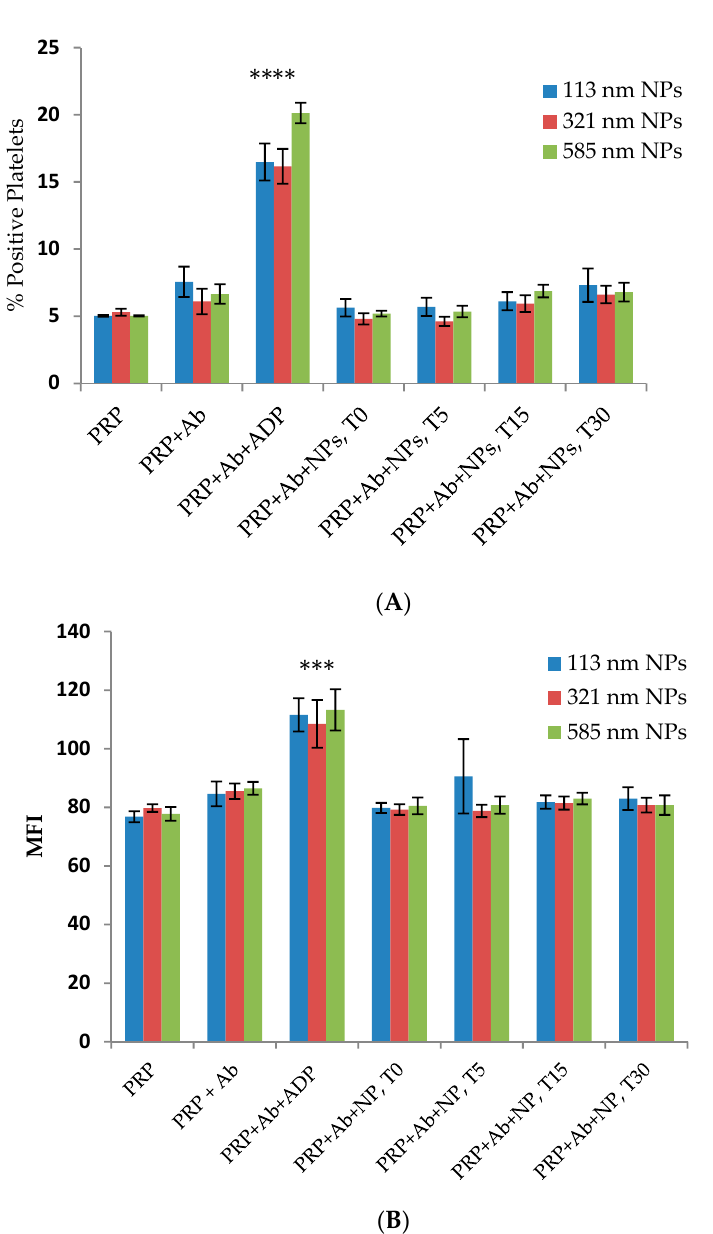
Figure 2. Flow cytometry analysis of the effect of size of PLGA ‐ PEG NPs at 2.2 mg/mL on platelet activation over time (T) in minutes. ( A ) % Positive platelets (% PP); ( B ) Mean fluorescence intensity (MFI). NPs were incubated with aliquots of resting platelets in PRP for 4 min without stirring prior to the addition of anti ‐ CD62P antibody (10 μ g/mL). Then, the reaction was terminated using 1% v / v FA at the specified time (T) intervals. % Positive platelets represents the percentage CD62P ‐ positive platelets in the total platelet population. *** p < 0.001 **** p < 0.0001 as compared with PRP+Ab (control) one ‐ way ANOVA followed by post hoc Tukey test.